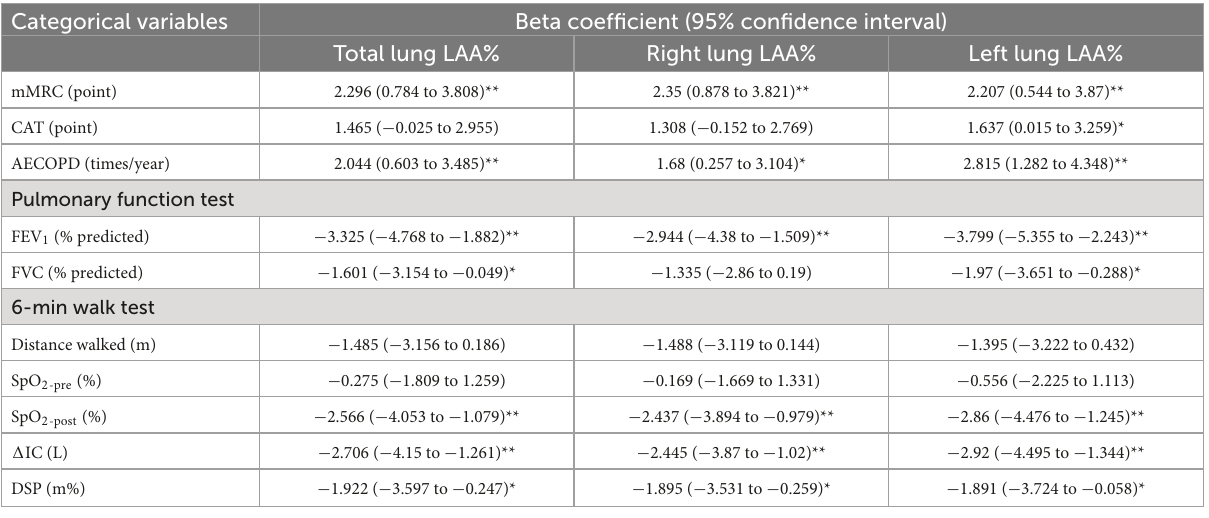
TABLE 3 Associations of details of the life quality, dyspnea sensation level, acute exacerbation frequency, pulmonary function test, and 6-min walk test with a low-attenuation area percentage (LAA%). Categorical variables